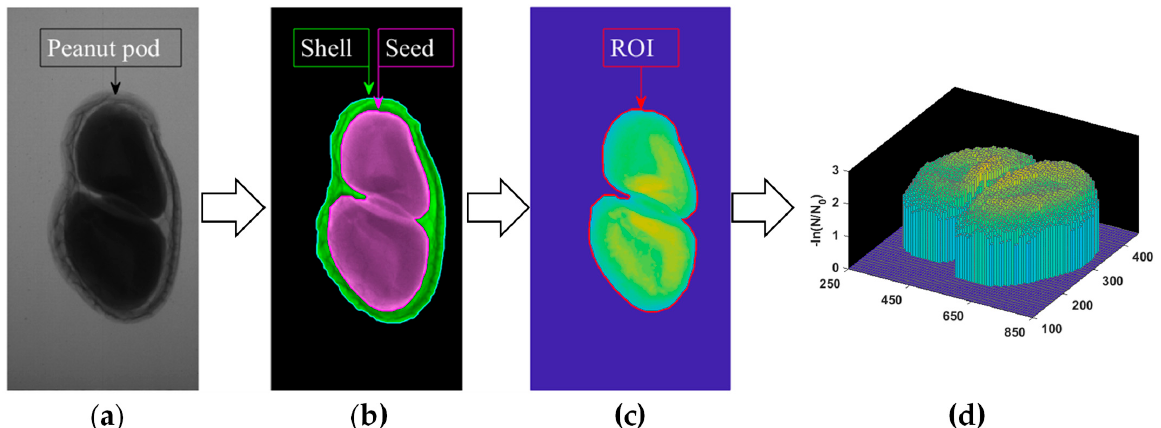
Figure 2. The segmentation and calculation process for a peanut X-ray image: ( a ) a raw X-ray image of a peanut pod. ( b ) Identification of the shell region in green and the seed region in purple. ( c ) Extracted seed region and marked as ROI. ( d ) Virtual volume at each pixel of ROI according to comprehensive attenuation index (CAI) value.